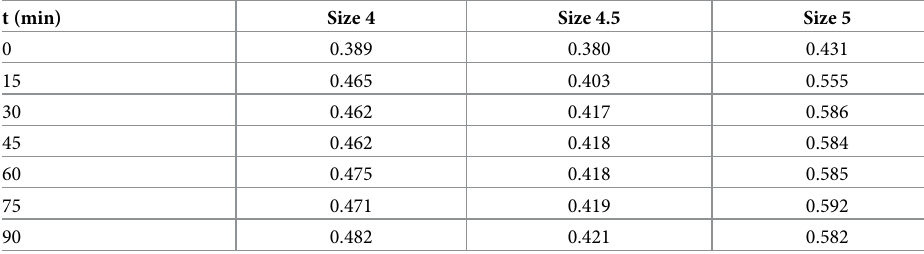
Table 4. Change in soccer ball mass (kg) during water